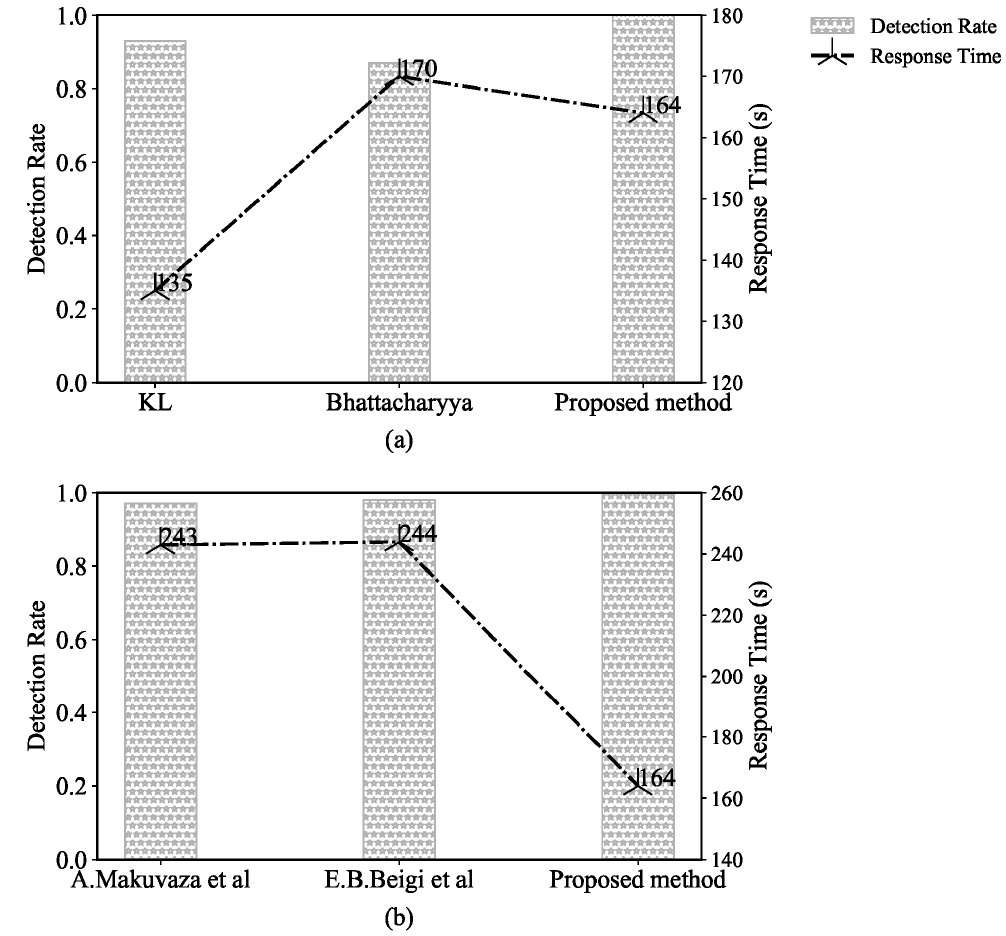
Figure 6. Detection rate of popular similarity methods: ( a ) Contrasting statistical methods; ( b ) con- trasting feature selection methods.